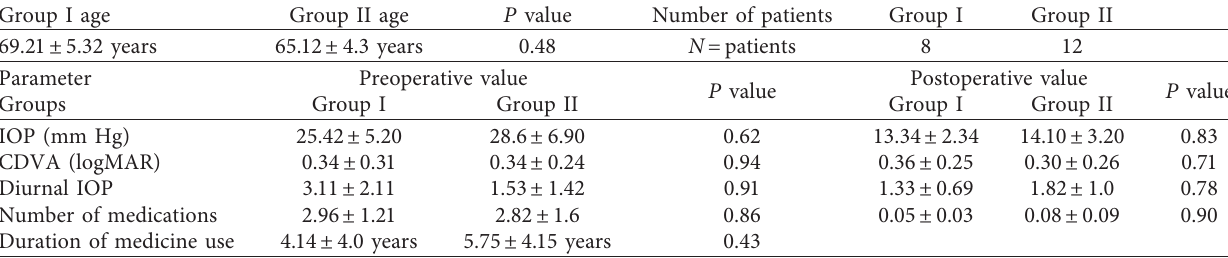
Table 3: Pseudophakic patients: descriptive